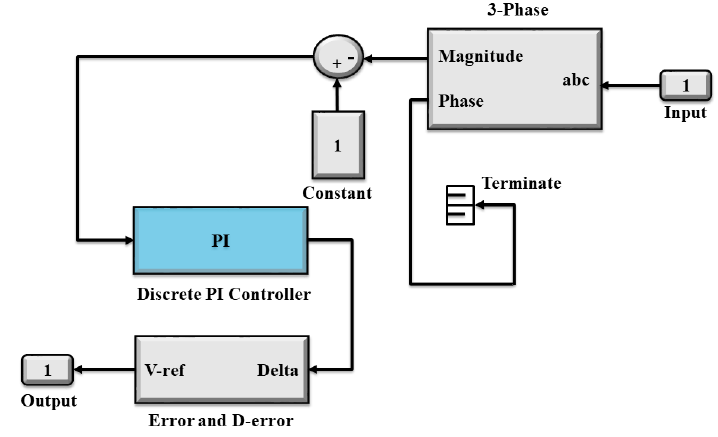
Figure 15. The P-I controller of HFC D-STATCOM.